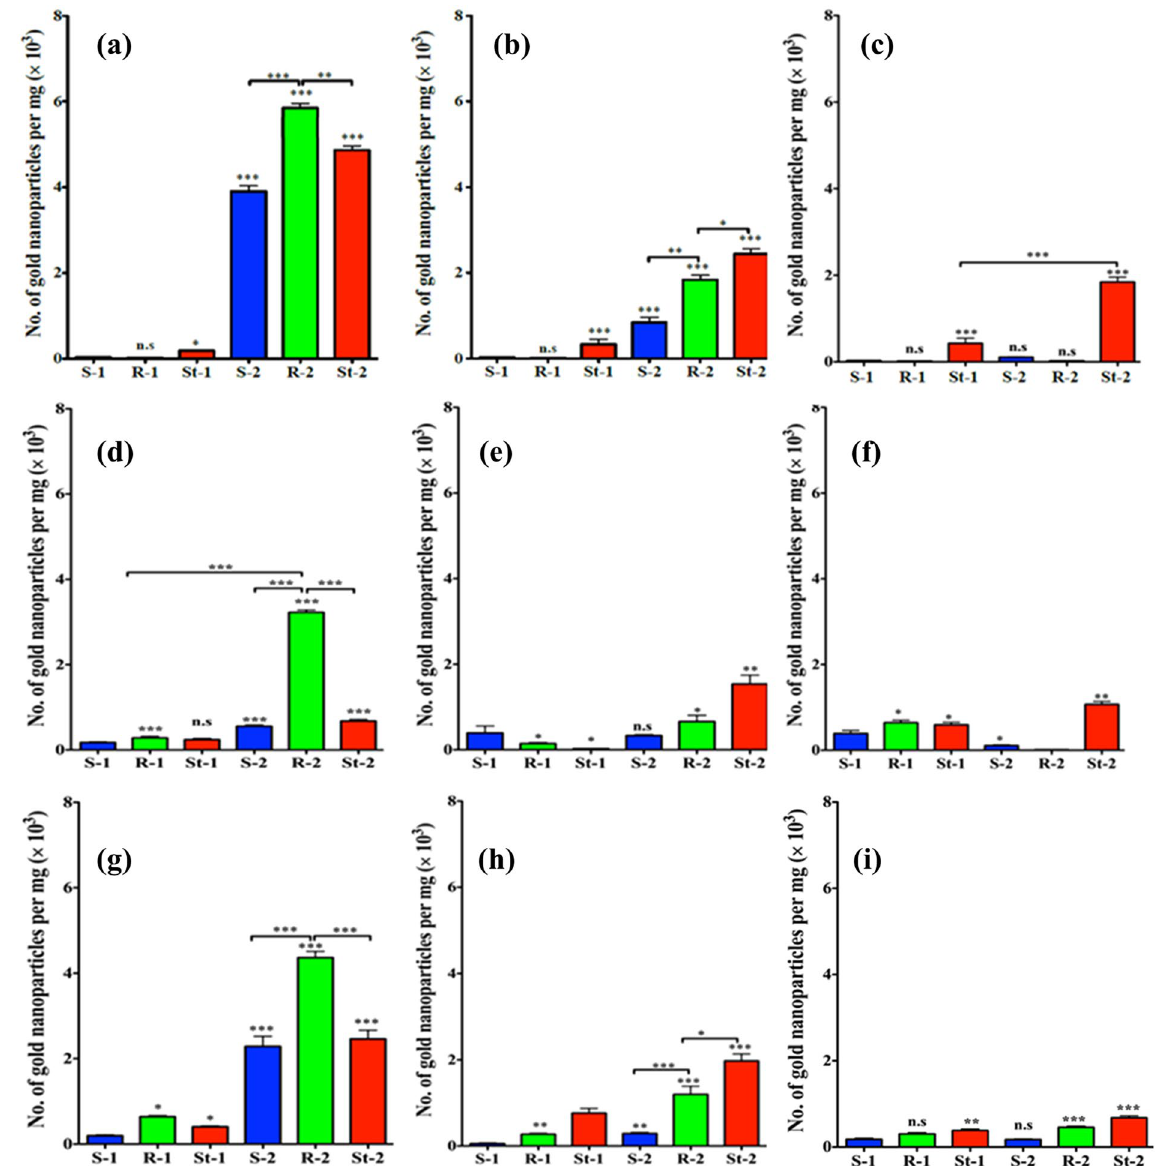
Figure 3. Statistical analysis of ICP-MS data of digestive system, heart and swimming bladder of zebrafish at different time intervals: ( a ) digestive system − 4 h; ( b ) digestive systm − 24 h; ( c ) digestive system − 48 h; ( d ) heart − 4 h; ( e ) heart − 24 h; ( f ) heart − 48 h; ( g ) swim bladder − 4 h; ( h ) swim bladder − 24 h; ( i ) swim bladder − 48 h. Data are presented as mean ± SEM for three independent experiments ( *** P < 0.001, ** P < 0.01 * P < 0.05 and n.s = not